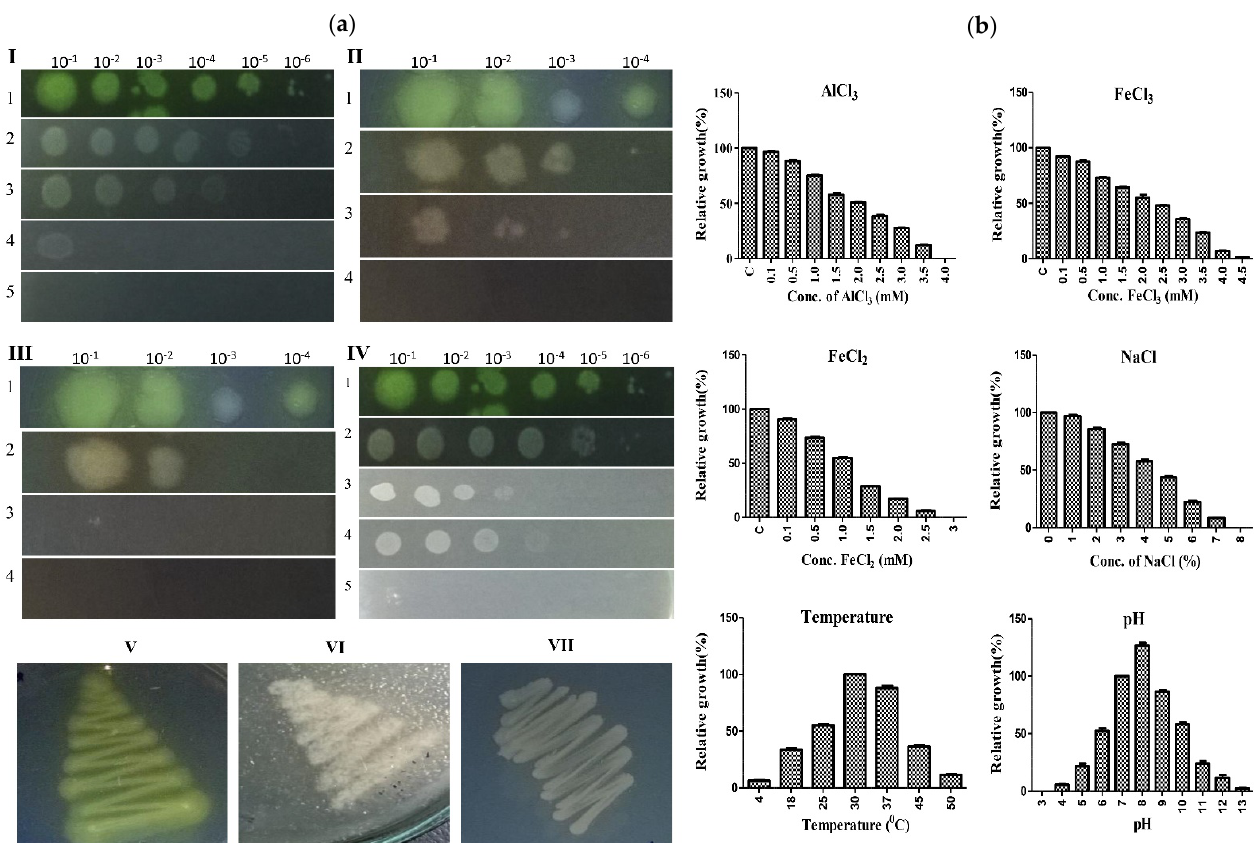
Figure 4. Growth profile of the bacterial strain A7 at different abiotic stress conditions. ( a ) Growth of A7 at different concentrations of metal compounds (FeCl 3 , FeCl 2 , AlCl 3 ), pH and temperature by Single Plate Serial Dilution Spotting (SP—SDS) and streaking plate inoculation method at 30 ± 2 °C for a particular incubation period in three biological replicates. (I) AlCl 3 (1 = control, 2 = 1 mM, 3 = 2 mM, 4 = 3 mM 5 = 4 mM) (at a dilutions of 10 − 1 to 10 − 6 ), (II) FeCl 3 (1 = control, 2 = 2 mM, 3 = 4 mM, 4 = 6 mM), (III) FeCl 2 (1 = control, 2 = 2 mM, 3 = 4 mM, 4 = 6 mM) (at a dilutions of 10 − 1 to 10 − 4 ), (IV) pH (1 = control, pH—7, 2 = pH—6, 3 = pH—5.5, 4 = pH—5, 5 = pH—4.5) (at a dilutions of 10 − 1 to 10 − 6 ), (V) Growth of the bacterial strain A7 at 30 °C as control, (VI) Growth of the bacterial strain A7 at 4 °C, (VII) Growth of the bacterial strain A7 at 50 °C after two days of incubation period. ( b ) Bar diagram showing Relative growth of the bacterial strain A7 at different concentrations of metal compounds (FeCl 3 , FeCl 2 , and AlCl 3 ), NaCl, Temperature and pH. Values are expressed as means (n = 3) ± Standard Error Mean (SEM). Table 5. Relative growth (RG) of the bacterial strain A7 on different abiotic stress conditions.